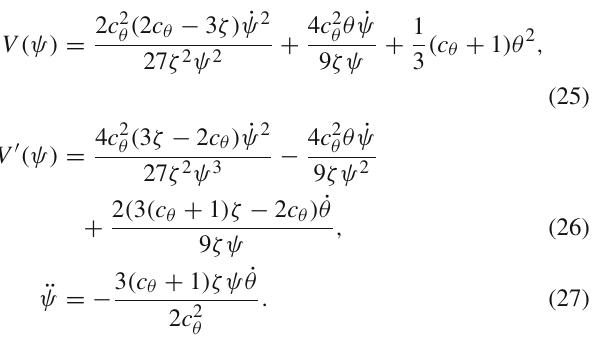
(cid:9) (cid:10) , 0 1 , dashed line is 2